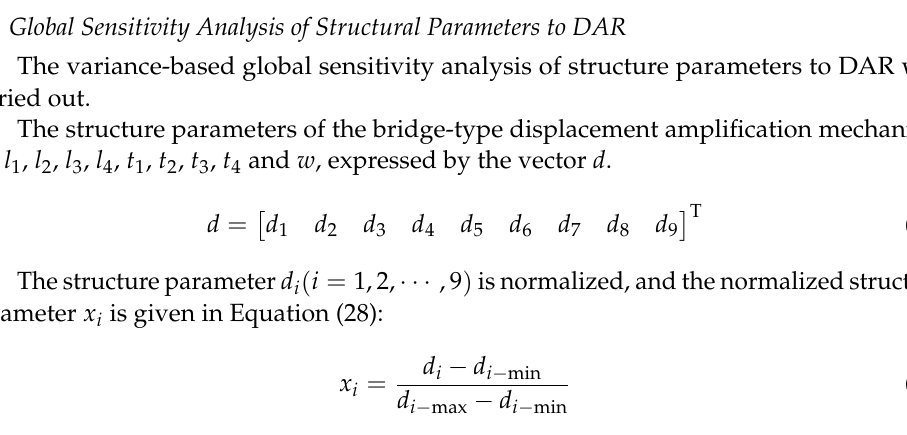
(cid:0) (cid:1) x i , x j represents the function value correspond-